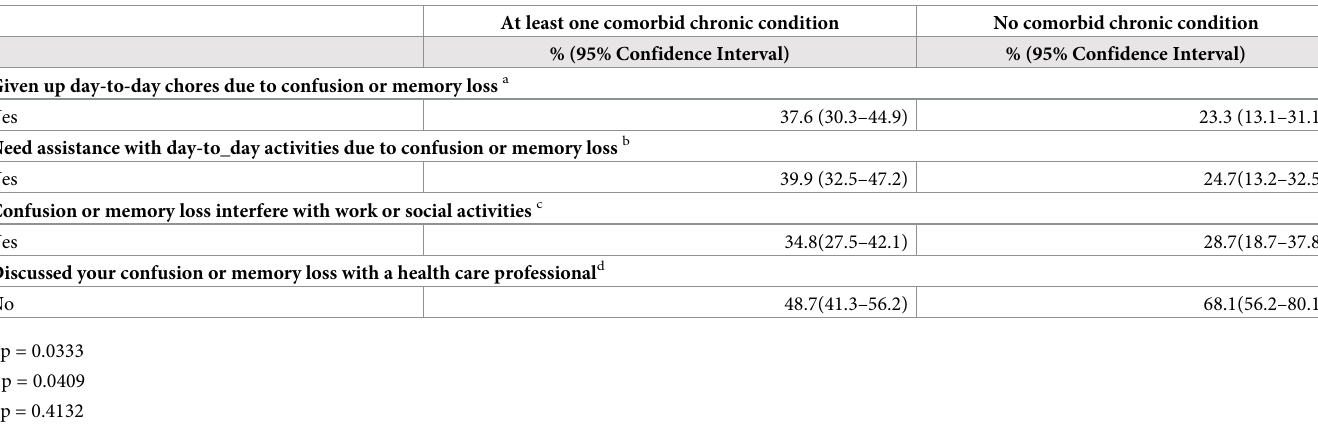
Table 3. SCD-related functional limitation in Delaware Adults aged � 45 years with subjective cognitive decline (SCD), by comorbid chronic condition status in preceding 12 months—Behavioral Risk Factor Surveillance System (combined data 2016 and 2020). At least one comorbid chronic condition No comorbid chronic condition % (95% Confidence